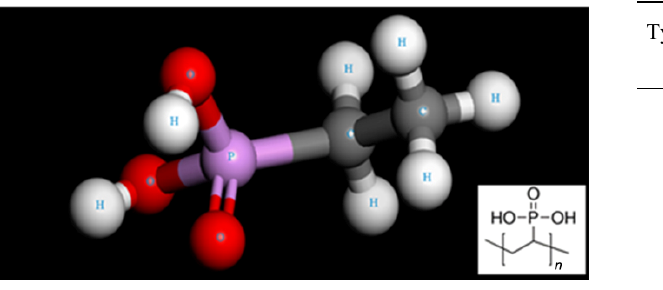
Table 1 Specific parameters of unit cells in different inorganic salt